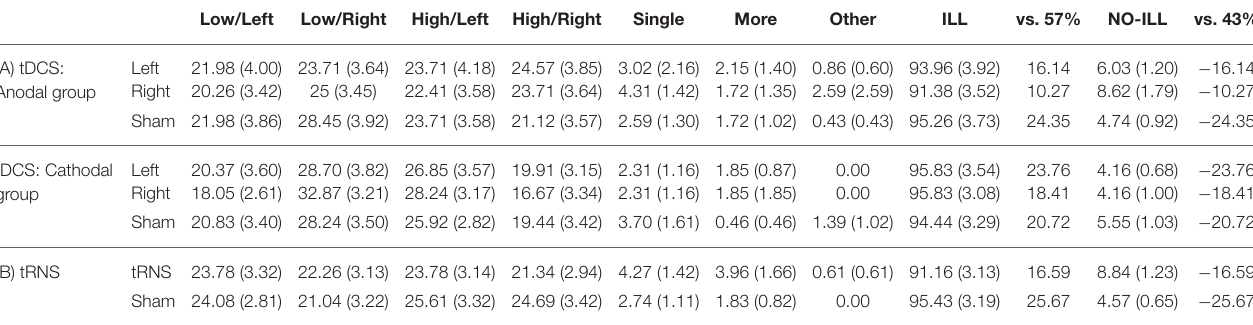
The upper panel represents the results collected in Experiment 1 (tDCS: Anodal/Cathodal stimulation applied over the Left auditory cortex, Right auditory cortex, and Sham condition). The lower panel represents the results collected in Experiment 2 (hf-tRNS and Sham condition). The rightmost columns represent the sum of the illusory responses (ILL: response categories from 1 to 4) and of the remaining non-illusory responses (NO-ILL: response categories from 5 to 7) in each stimulation condition, and the respective t-values when ILL was compared to the reference value of 57% and NO-ILL was compared to the reference value of 43% (Anodal tDCS: df = 28, Cathodal tDCS: df = 26, tRNS: df = 40; for all comparisons: p <